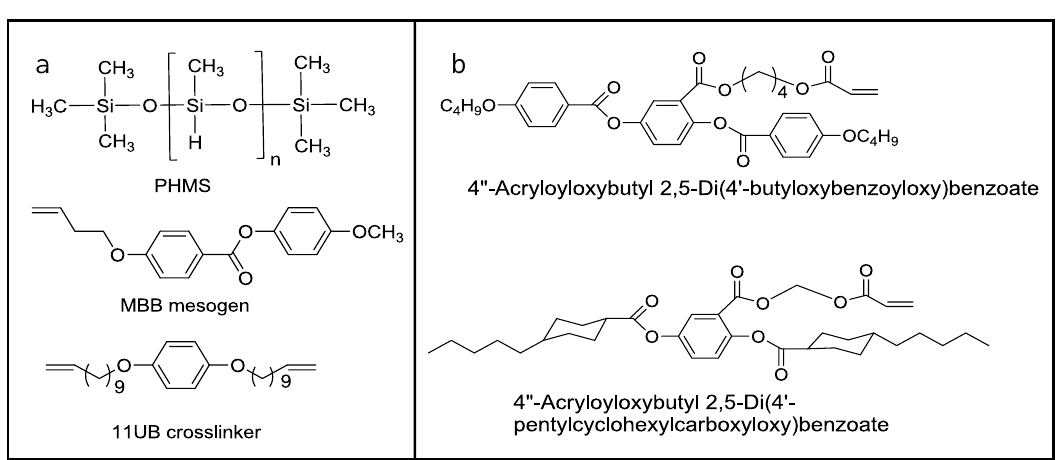
Figure 1. Chemical structure of LCE starting materials: ( a ) polysiloxane-based LCE, and ( b ) LCE with acrylate